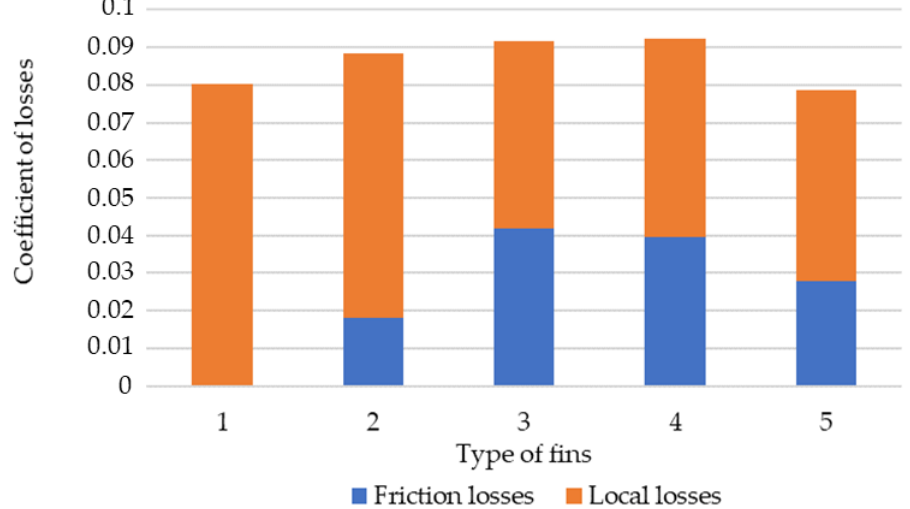
Figure 10. The composition of hydraulic resistance losses when using different types of fins.